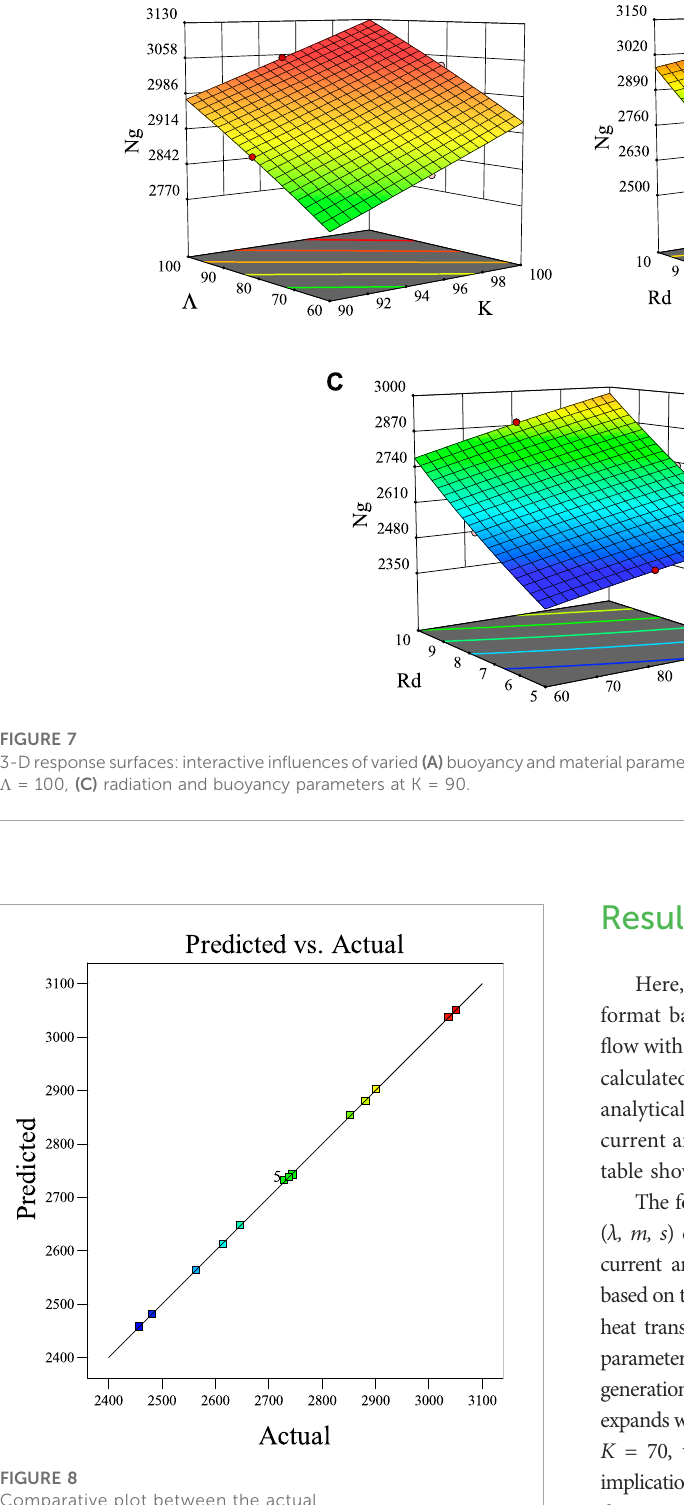
FIGURE 8 Comparative plot between the actual and predicted model Ng for the response surface quadratic